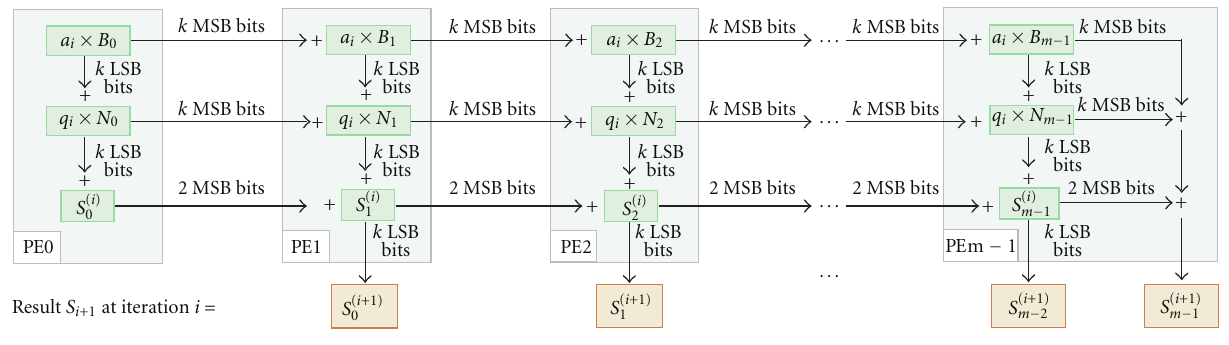
Figure 2: Arithmetic operations of the Processing Elements to obtain S i + 1 = ( S i + q i × N + a i × B ) / 2 k